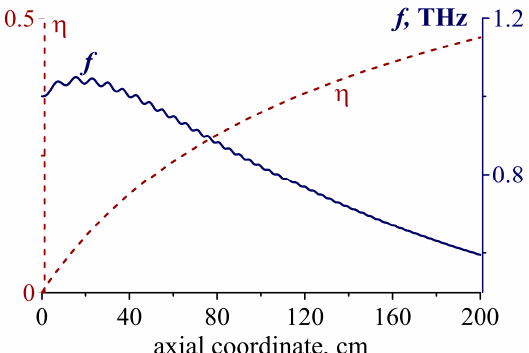
Figure 3. Undulator radiation of the moving plane: current radiation frequency and efficiency for an initial particle energy of 6 MeV, transverse velocity β ⊥ 0 = 1 γ amplitude of undulator field H 0 = 40.5 kOe, and H u = 1 kOe.